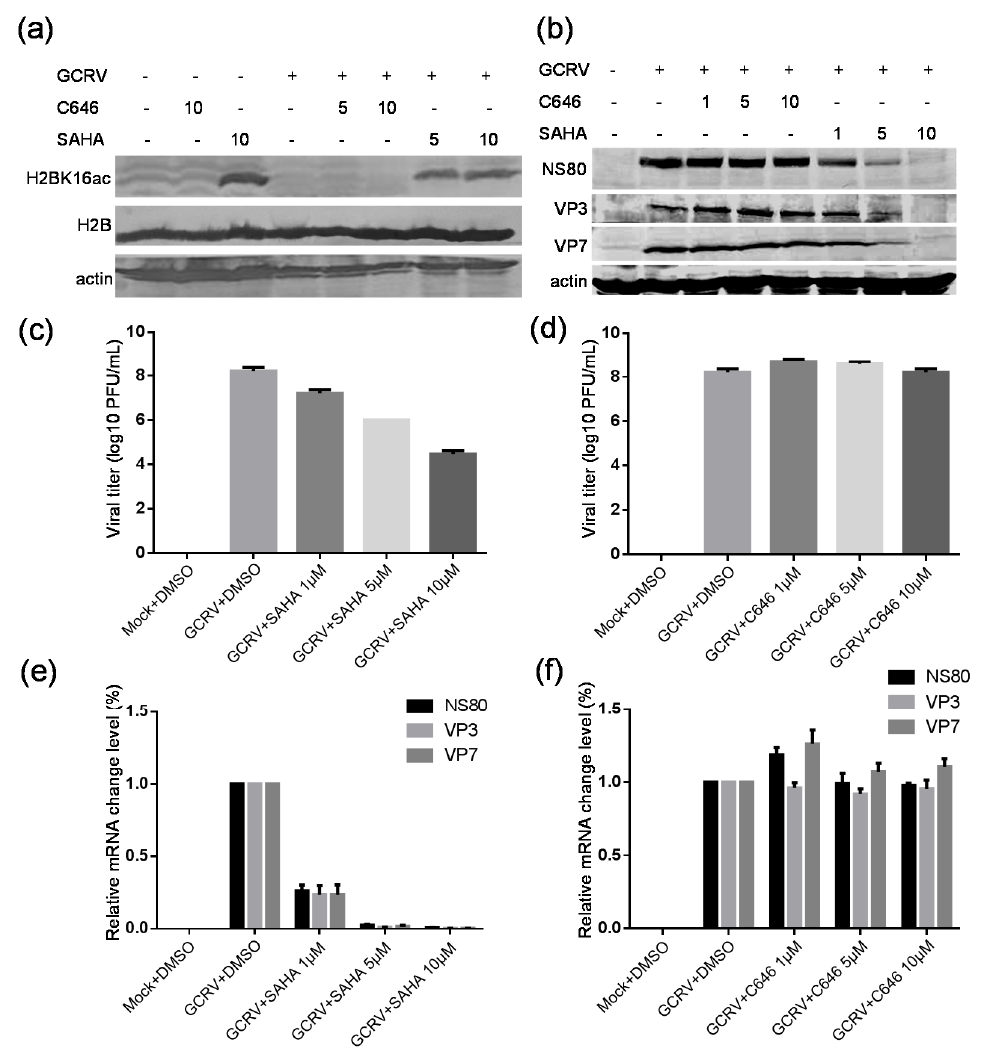
Figure 7. The effect of SAHA or C646 treatment on GCRV infection in CIK cells. ( a ) The influence of C646 and SAHA on H2BK16 acetylation. Cells were infected or mock infected with GCRV at a multiplicity of infection (MOI) of 1 in the presence or absence of SAHA or C646 at the indicated concentrations. Then cells were collected at 18 h post-infection and subjected to Western blotting analysis by the indicated antibodies; ( b ) Cells were infected with GCRV at an MOI of 1 in the presence or absence of SAHA or C646 at the indicated concentrations. Then cells were collected at 18 h post-infection and subjected to Western blotting analysis for the expression of NS80, VP3 and VP7 by the indicated antibodies; ( c – f ) Cells were infected with GCRV at an MOI of 1 in the presence of SAHA ( c , e ) or C646 ( d , f ). Then the cultured cell supernatants or cells were collected respectively at 18 h post-infection (h.p.i.) and subjected to viral plaque assay ( c , d ) or quantitative RT-PCR for NS80, VP3 and VP7 transcript level analysis ( e , f ). Data shown are mean ± standard deviation of three individual experiments.